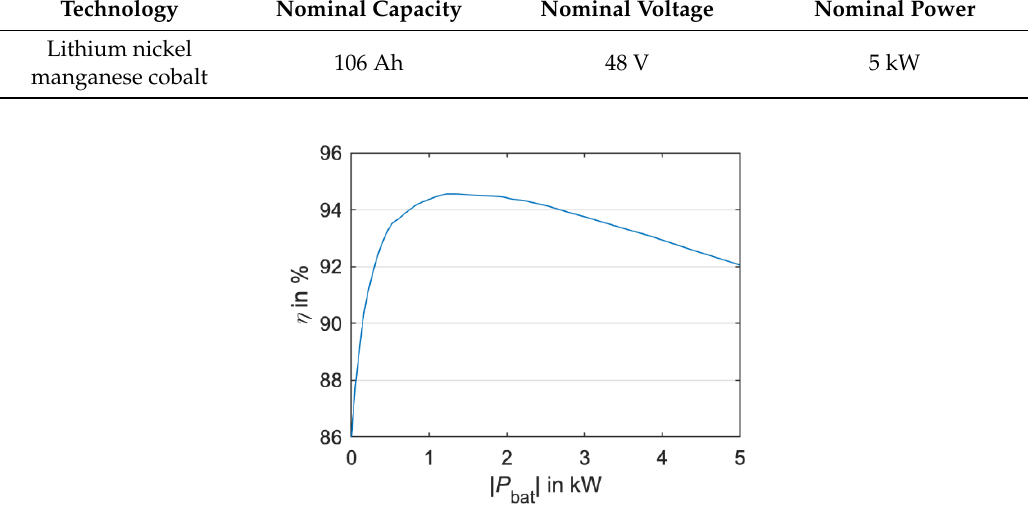
Figure 5. E ffi ciency curve of the battery inverter. Figure 5. Efficiency curve of the battery inverter. Table 1. Specifications of the modeled battery.